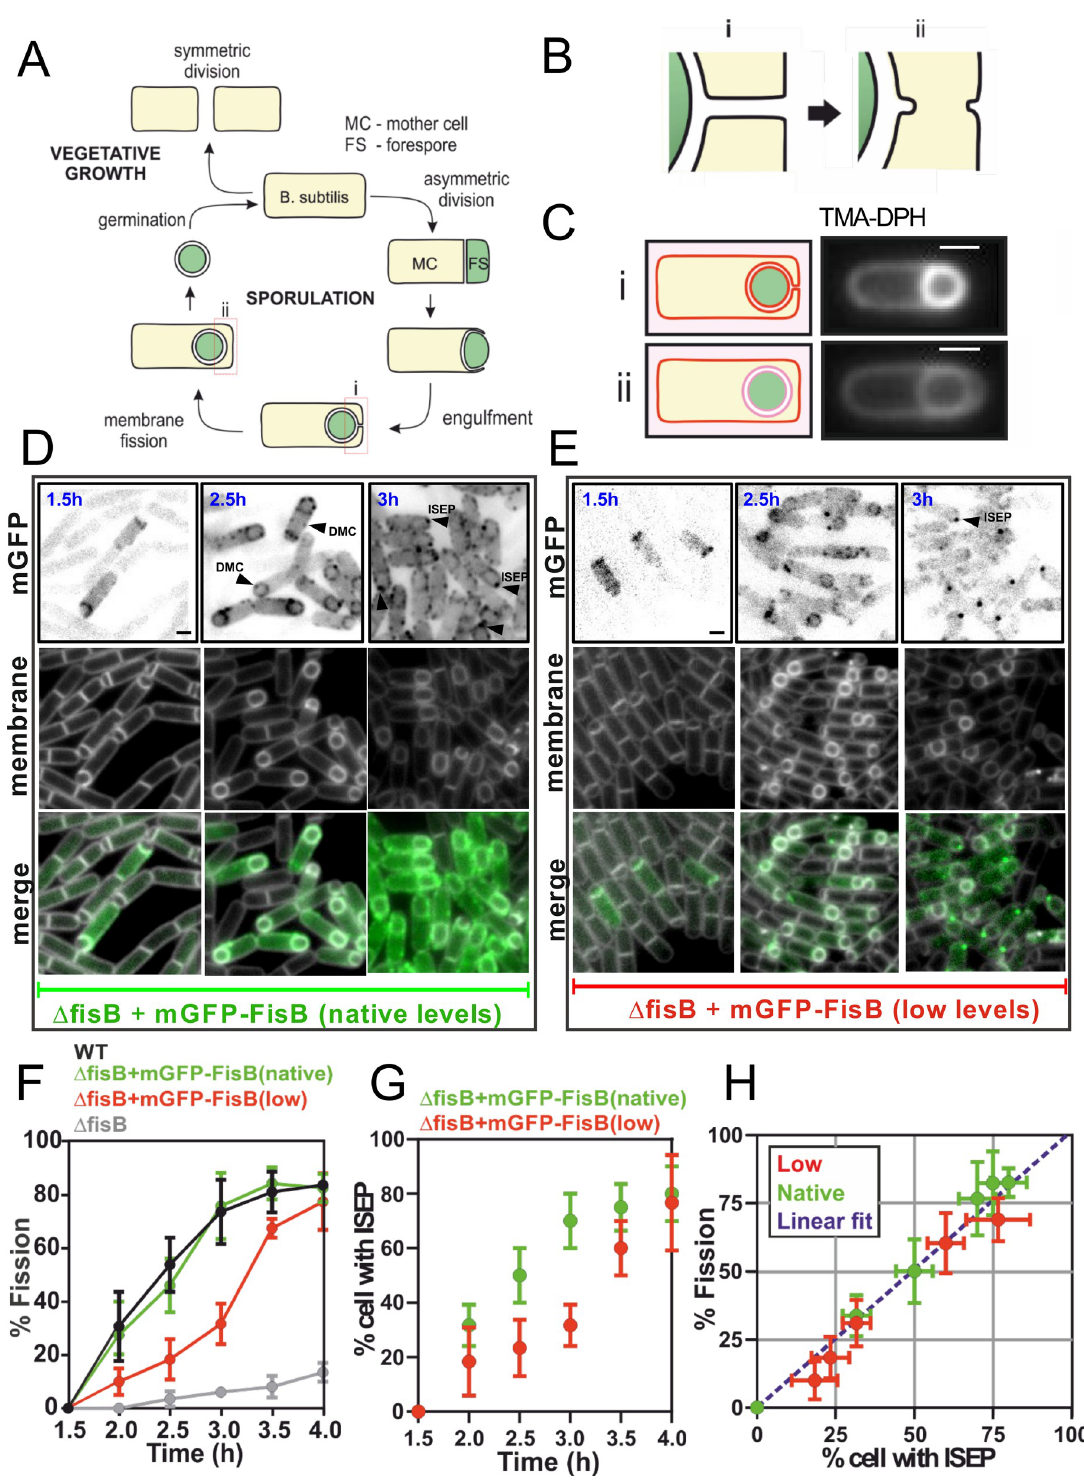
Fig 1. Membrane fission during sporulation is nearly always accompanied by accumulation of a FisB cluster at the fission site. (A) Vegetatively growing cells enter sporulation when nutrients become scarce. Asymmetric division creates an FS and an MC. The MC engulfs the FC in a phagocytosis-like event. At the end of engulfment, a membrane neck connects the engulfment membrane to the rest of the MC (i). Fission of the neck (ii) releases the FS, now surrounded by 2 membranes, into the MC cytoplasm. Once the FS becomes a